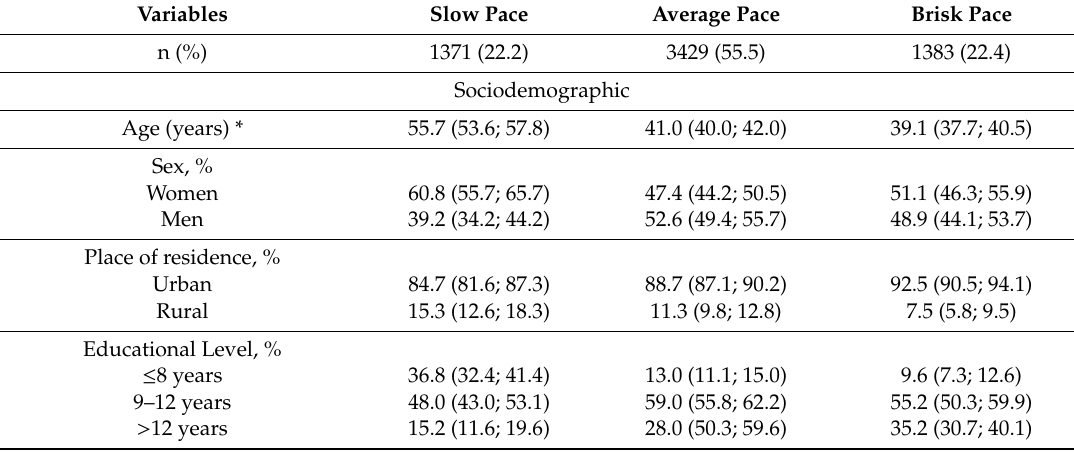
Table 1. Characterisation of the population by walking